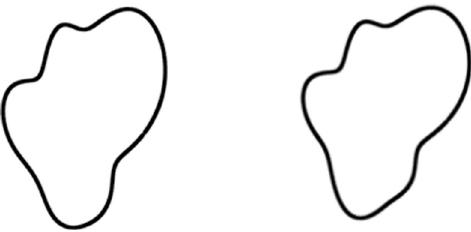
Fig 6. Shape pair with similar contour features. The first member of the pair was generated by moving 12 control points in a circle towards or away from the center and fitting cubic splines between the 12 control points. The second member of the pair was generated by moving two adjacent control points from the first member a random direction and fitting a new set of cubic splines between the resulting dozen control